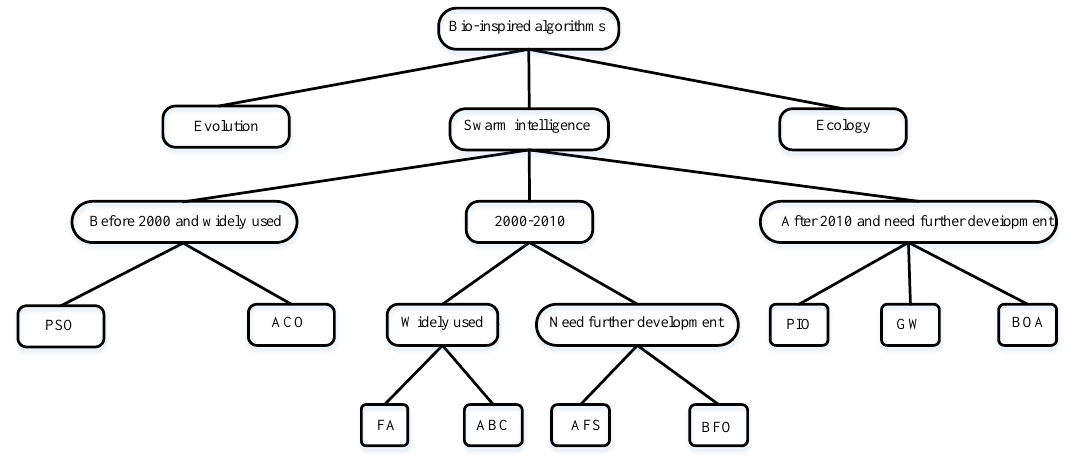
Figure 2. Taxonomy of SI-based computation algorithms.